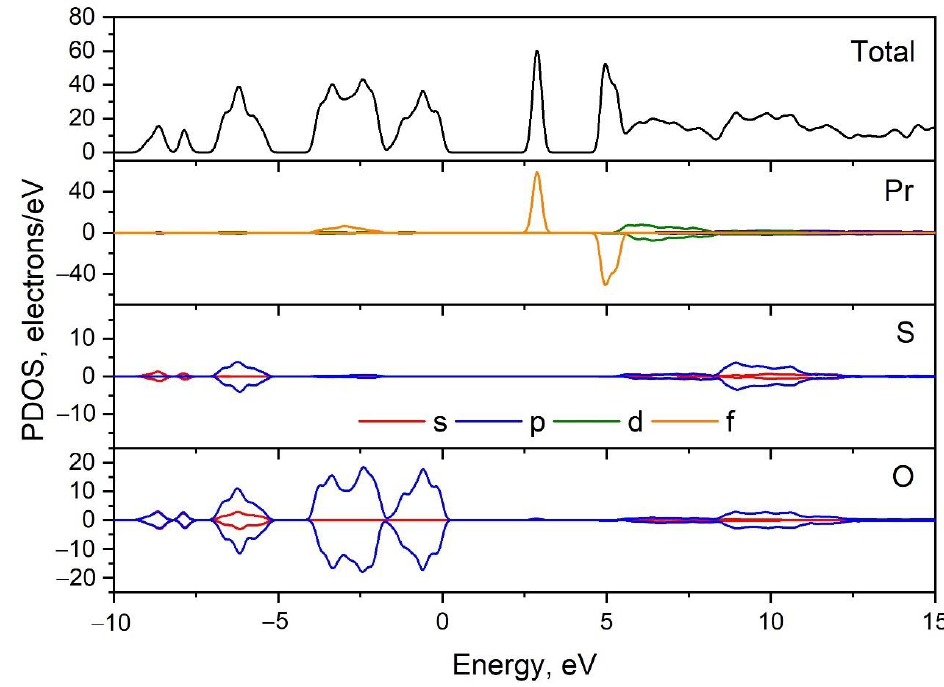
Figure 6. Calculated partial density of states in Pr 2 (SO 4 ) 3 .